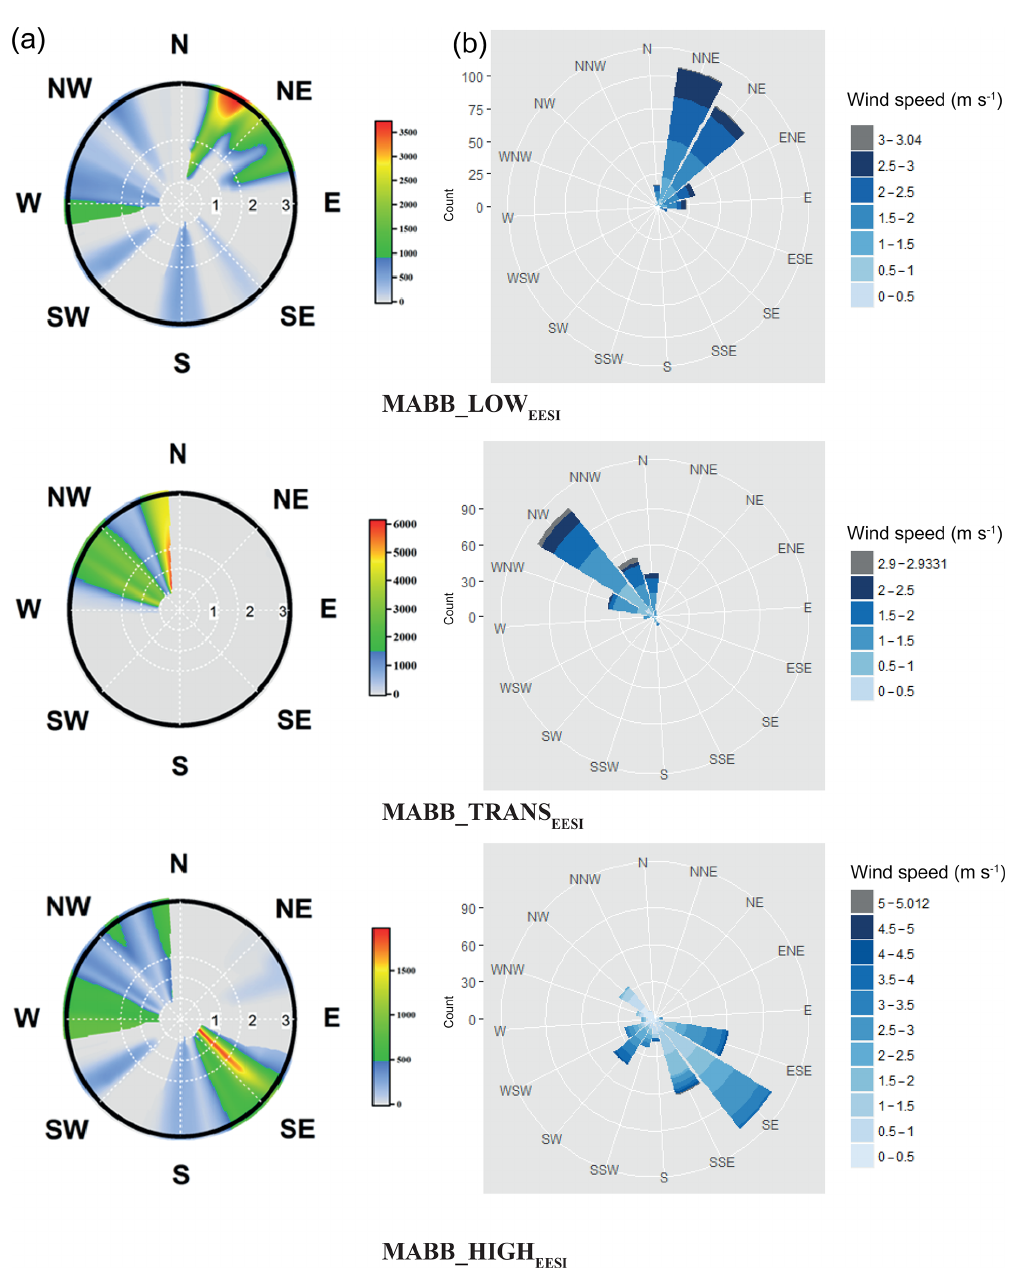
Figure 7. Wind analysis results using the SWIM model on the concentrations of MABB_LOW EESI , MABB_TRANS EESI , and MABB_HIGH EESI . (a) Wind direction combined with frequency; wind speed is in meters per second. (b) The wind speed and wind di-